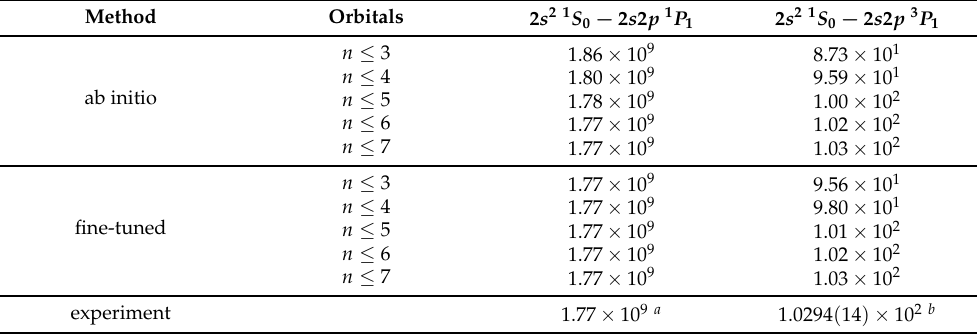
Table 3. The 2 s 2 1 S 0 − 2 s 2 p 1,3 P 1 transition rates in C III as functions of the increasing orbital set from ab initio and fine-tuned CI